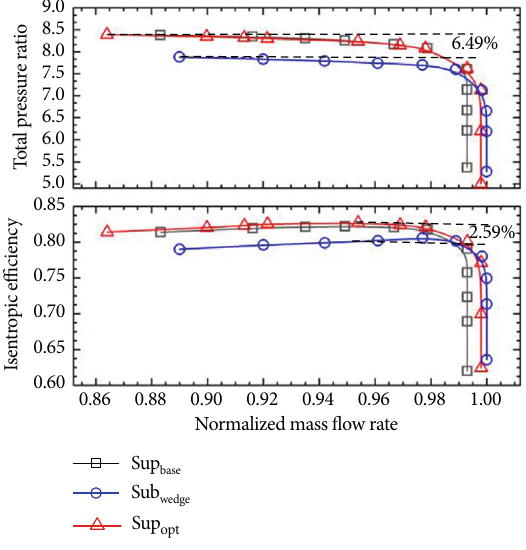
Figure 17: Performance comparisons for the supersonic compressor.